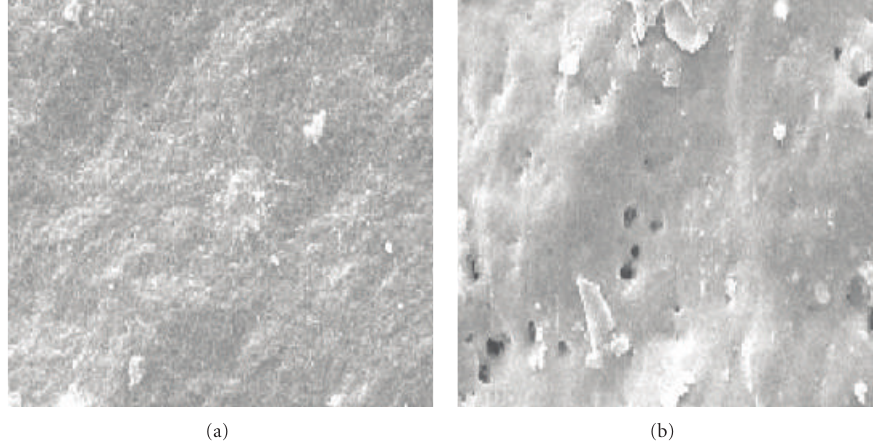
Figure 7: SEM of PAN/MMT nanocomposites (a) before and (b) after 30 days biodegradation.